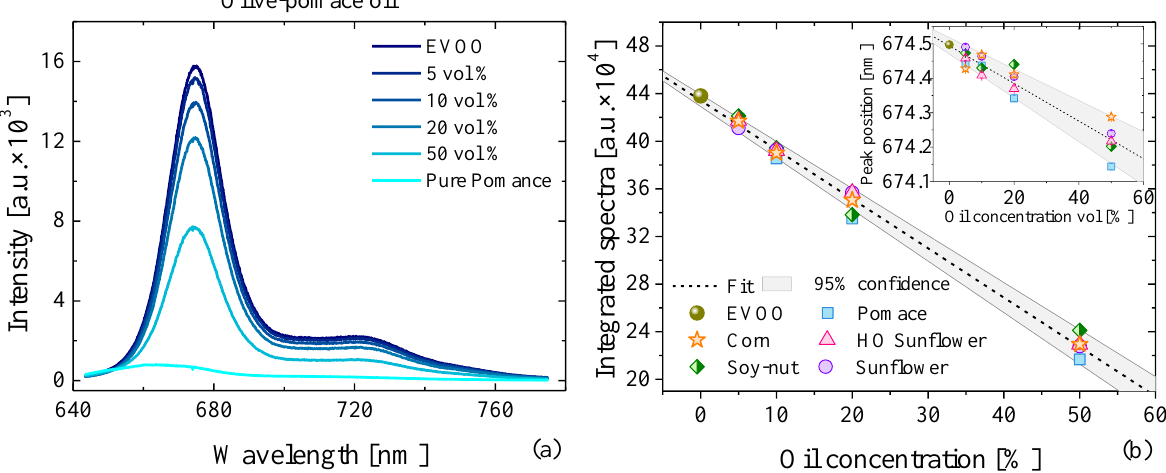
Figure 1. ( a ) Photoluminescence spectra of EVOO adulterated with different concentrations of olive- pomace oil. ( b ) Integrated photoluminescence spectra of the different oil mixtures as a function of the adulterant-oil concentration. The light-grey shaded region represents the 95% range of confidence region around the best-fit line. (Inset) peak position of the PL spectra as a function of adulterant- oil